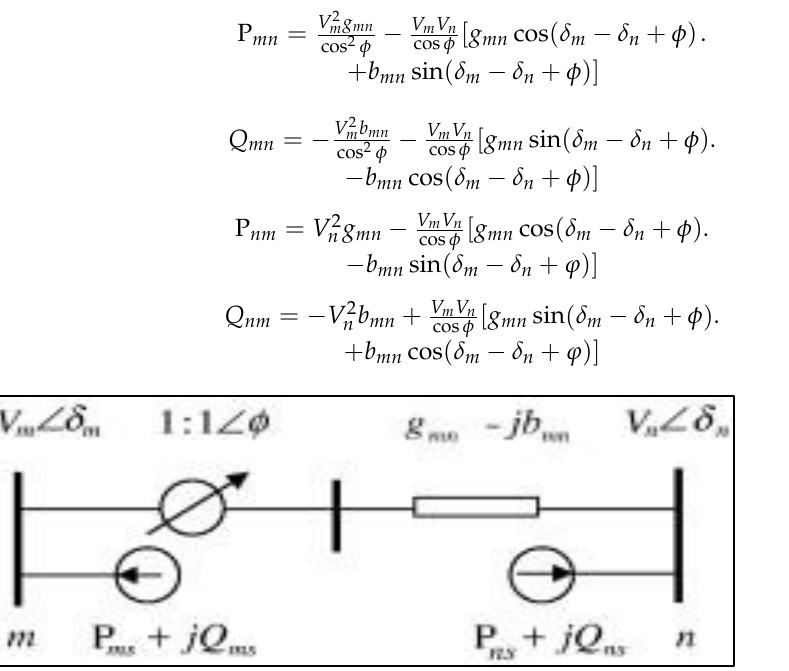
Figure 5. Model of TCP [23].